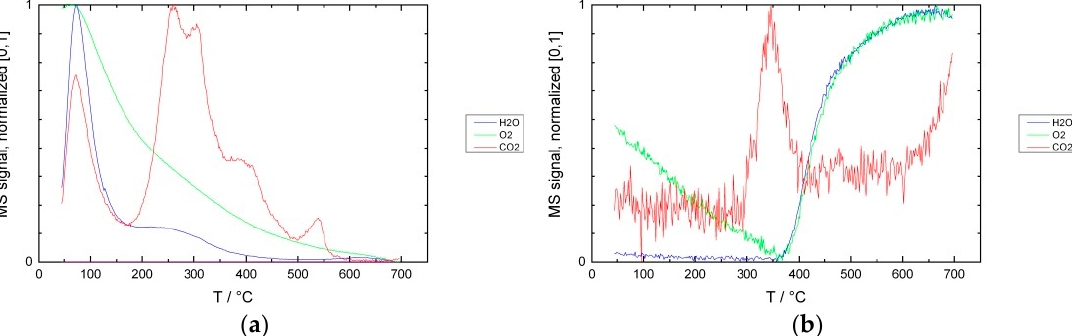
Figure 2. TPD in He + 12.5 vol% O 2 after exposure to ambient air ( a ), subsequent measurement ( b